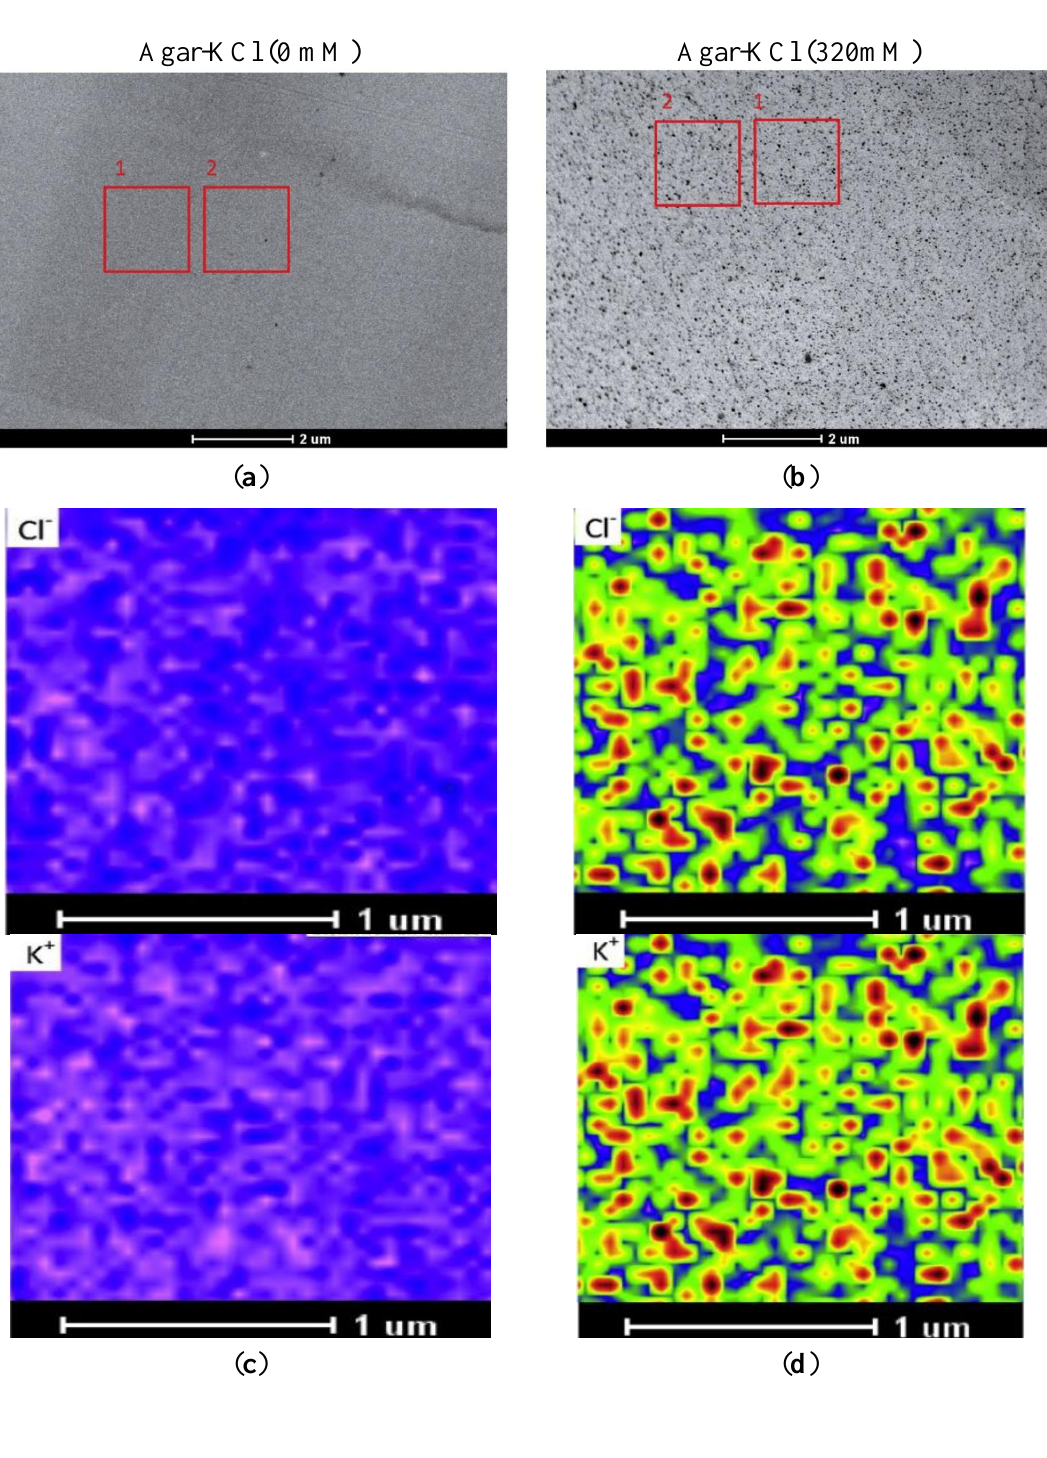
Figure 1. Representative STEM images ( a , b ) and elemental images ( c , d ) of 5% agar containing 0 or 320 mM KCl. STEM images with frame 1 showing the area for drift correction and frame 2 the measuring area. Elemental images of X-ray intensities with the scale fixed between the maximum (black) and minimum pixel intensities (violet) in a range of 25–1000 for Cl − and 20–1000 for K +